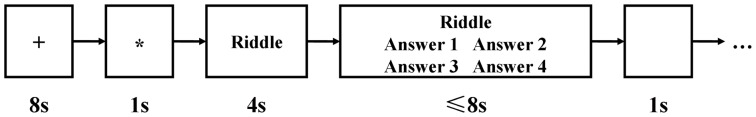
The flow map of the formal experiment.